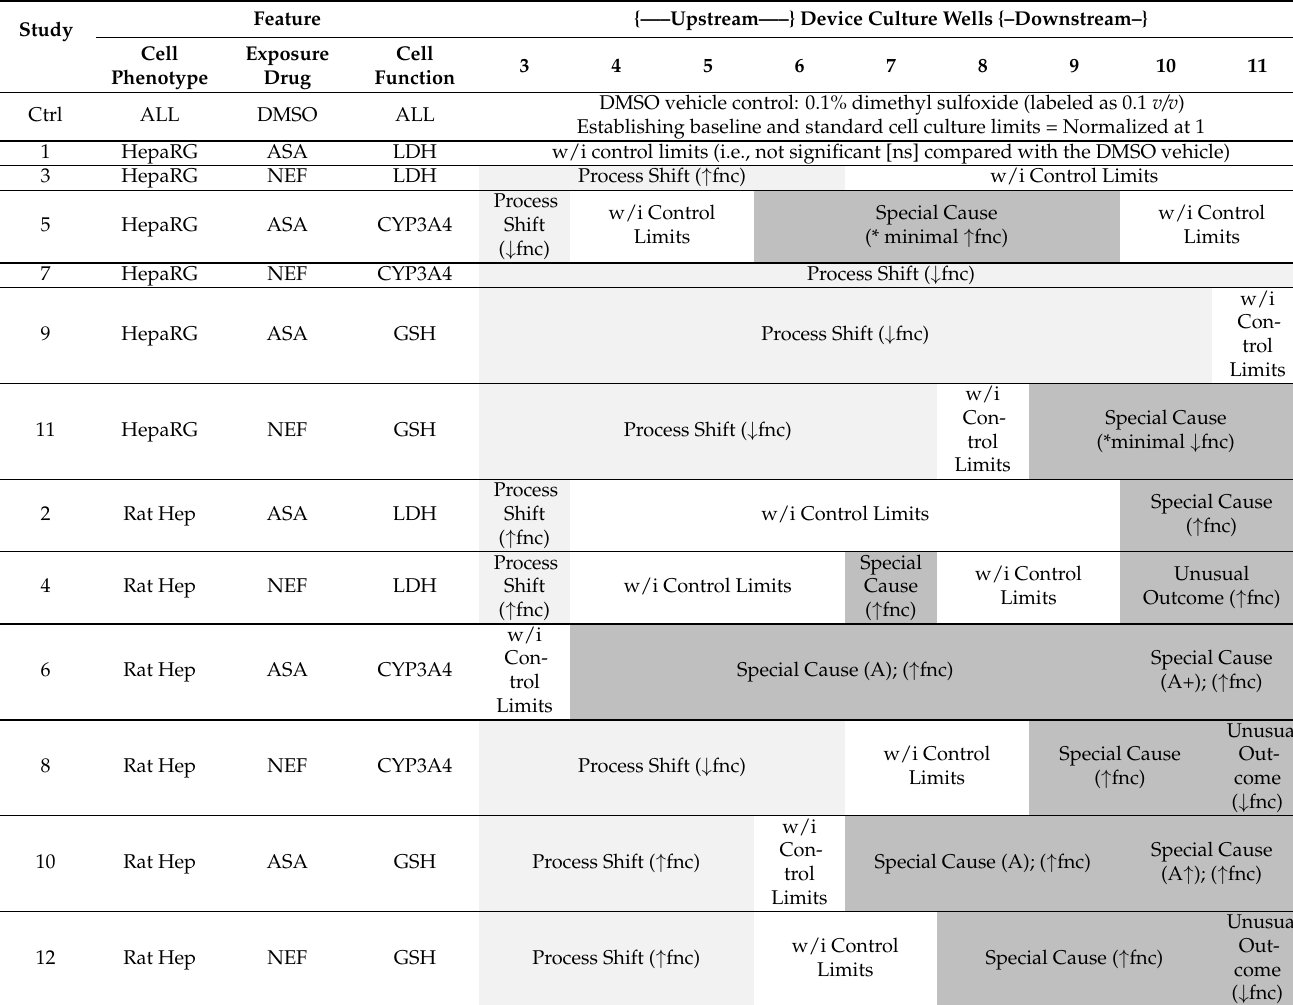
Table 9. Summary of trending responses and predictable exposure stimuli using cell-based screening indicators LDH, CYP3A4, and GSH. Coalesced cell function indicator data from Figures